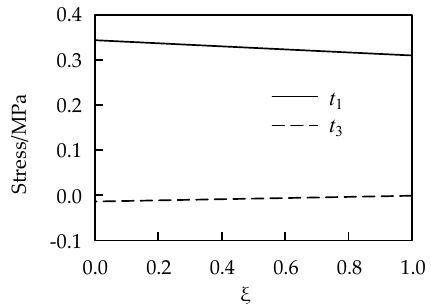
Materials 2020 , 13 , x FOR PEER REVIEW Figure 12. Exact solution of stresses of the balloon. Figure 12. Exact solution of stresses of the balloon.